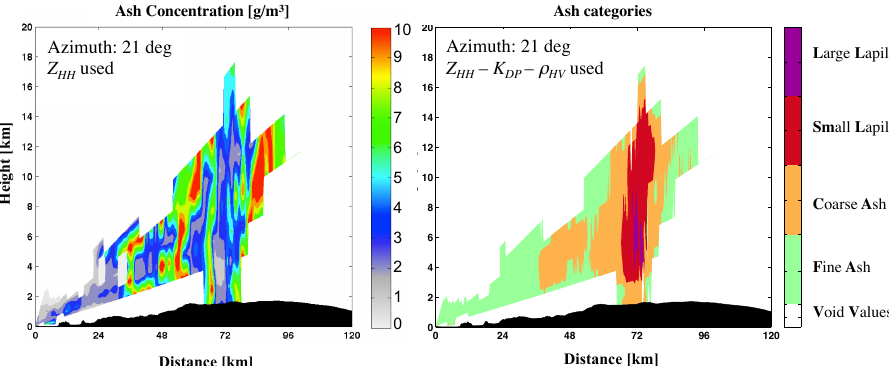
Fig. 8. (Left) ash mass concentration in (gm − 3 ) and (right) ash categories from the DPX radar acquisition at the 07:12UTC on 22 May 2011 at the Grímsvötn site (Iceland). Ash categories are large lapilli, small lapilli, coarse ash and fine ash with average equivalent diameter in millimetres of 10, 1, 0.1, 0.01, respectively. The ash mass concentration on the left panel is estimated using C a = a · Z b “ a ” and “ b ”, whose values depend on the ash categories shown on the right panel.